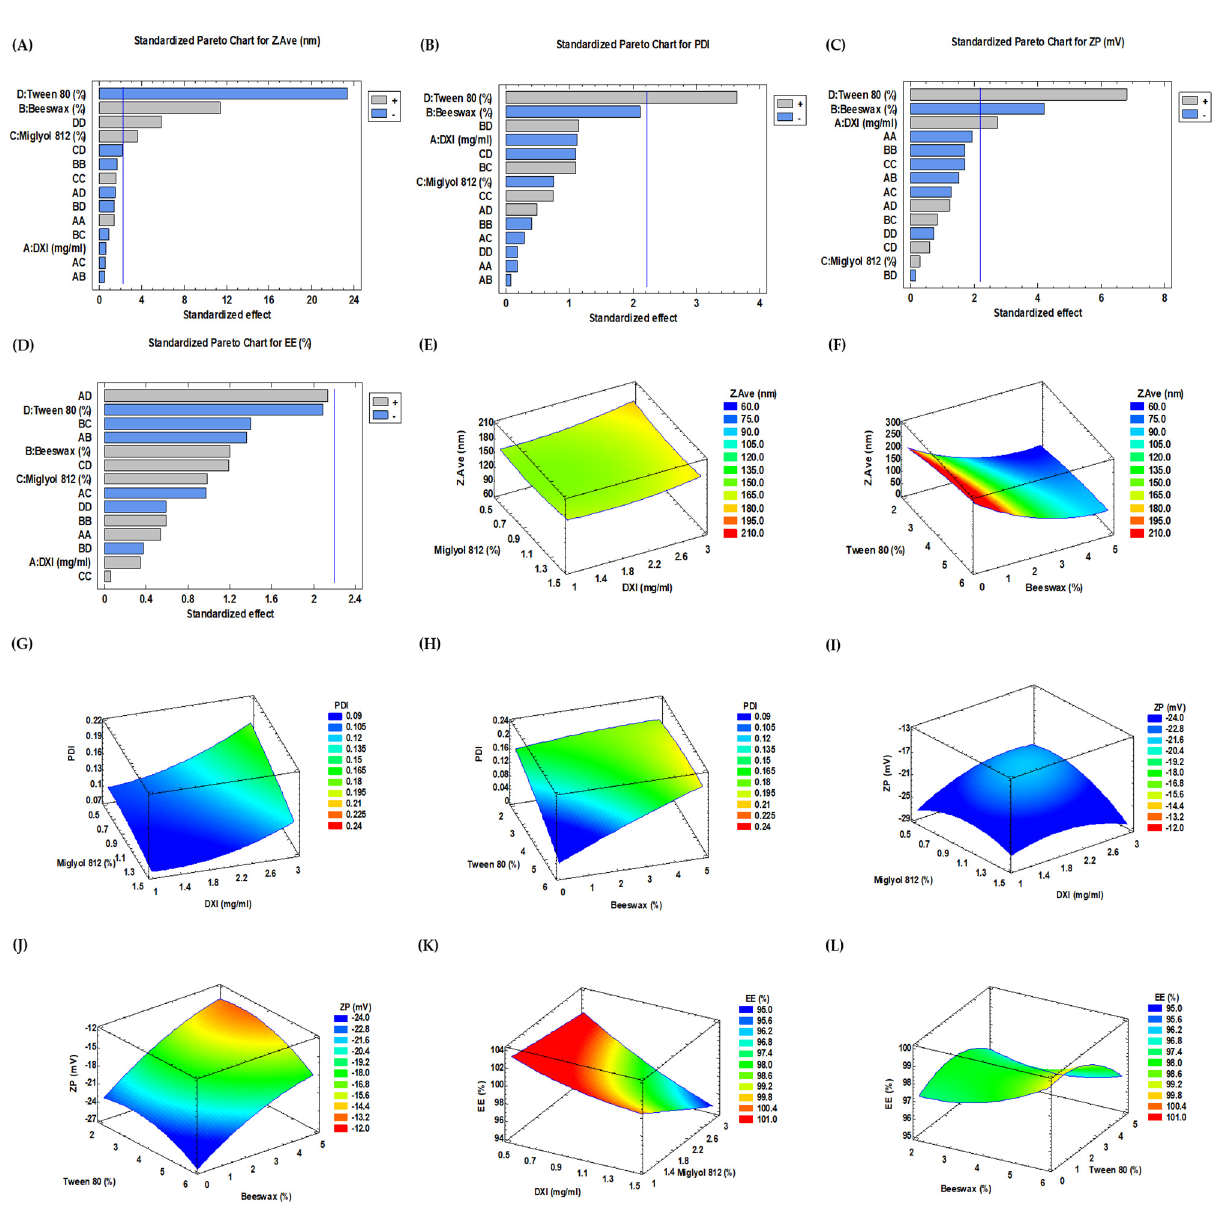
Figure 2. ( A – D ) Pareto chart shows positive and negative influence of dexibuprofen (DXI), Miglyol 812, Tween 80 and beeswax on the particle size (Z ave ), polydispersity index (PDI), zeta potential (ZP) and encapsulation efficiency (EE). ( E – L ) Surface response plots denoting changes in Z ave , PDI, ZP and EE during different concentrations of DXI, Miglyol 812, Tween 80 and beeswax. ( A ) Pareto chart for Z Ave ; ( B ) Pareto chart for PDI; ( C ) Pareto chart for ZP; ( D ) Pareto chart for EE. ( E , F ) Surface response plot for Z Ave ; ( G , H ) surface response plot for PDI; ( I , J ) surface response plot for ZP; ( K , L ) surface response plot for EE. In the Pareto chart, a bar crossing the blue line is considered a significant effect.